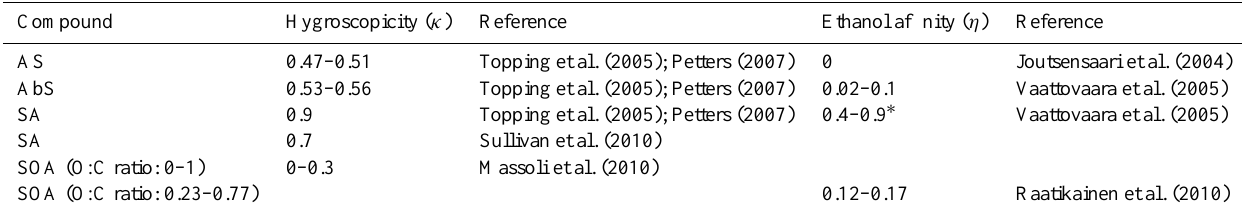
Table 2. Typical atmospheric inorganic (ammonium sulphate (AS), ammonium bisulphate (AbS), sulphuric acid (SA)) and SOA (with different O : C ratios) compounds hygroscopicities and ethanol affinities. ( ∗ extrapolated (from 20–50nm) from Vaattovaara et al.,